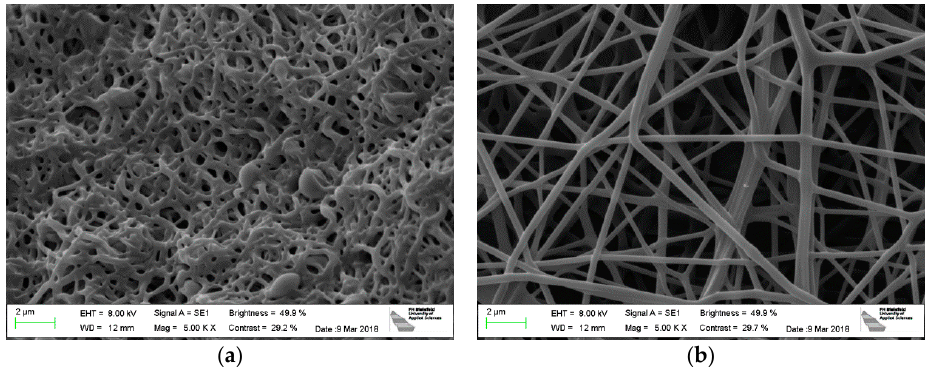
Figure 2. PAN nanofiber mats after stabilization: ( a ) electrospun on PP (substrate separated before stabilization); ( b ) electrospun on aluminum foil (substrate not removed before stabilization).